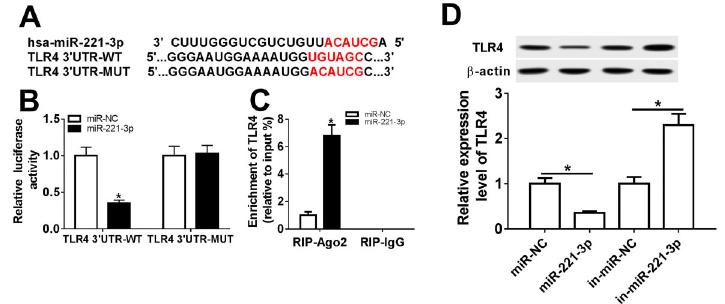
Figure 3. TLR4 was a target of miR-221-3p. A , The binding sites and mutant binding sites between miR-221-3p and TLR4 are shown. B , The luciferase activities of TLR4 3 0 UTR-WT/MUT (wild type/mutated) were determined by Dual-Luciferase Reporter assay. C , RNA immunoprecipitation assay was performed to detect the enrichment of TLR4. D , TLR4 protein level was tested using western blot analysis. Data are reported as means ± SD from three independent experiments. *P o 0.05